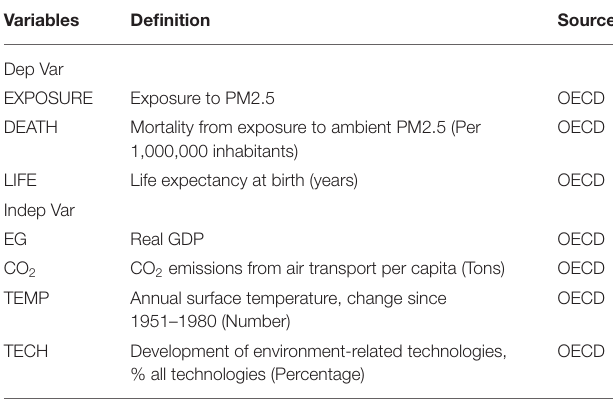
TABLE 1 | Data source.